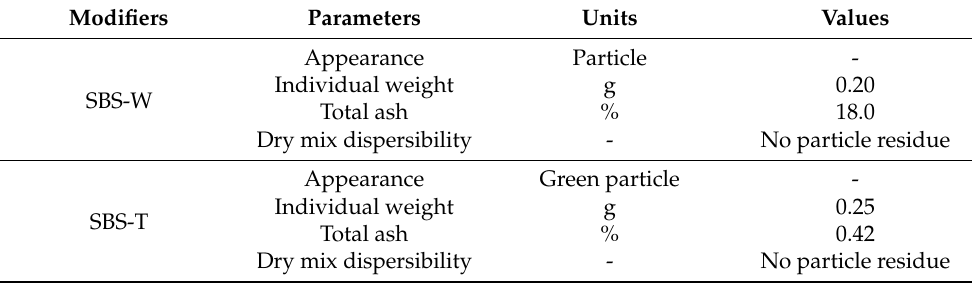
Table 3. Technical information of fast melting